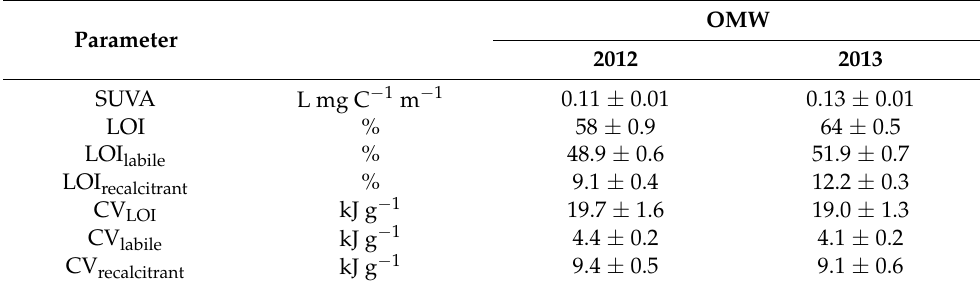
Table 1. Selected properties of the OMW used in 2012 and 2013 (preceded the detailed survey). Other properties of the OMW used during 2012–2016 are found in Zipori et al. [11]. LOI, loss on ignition; CV, calorific